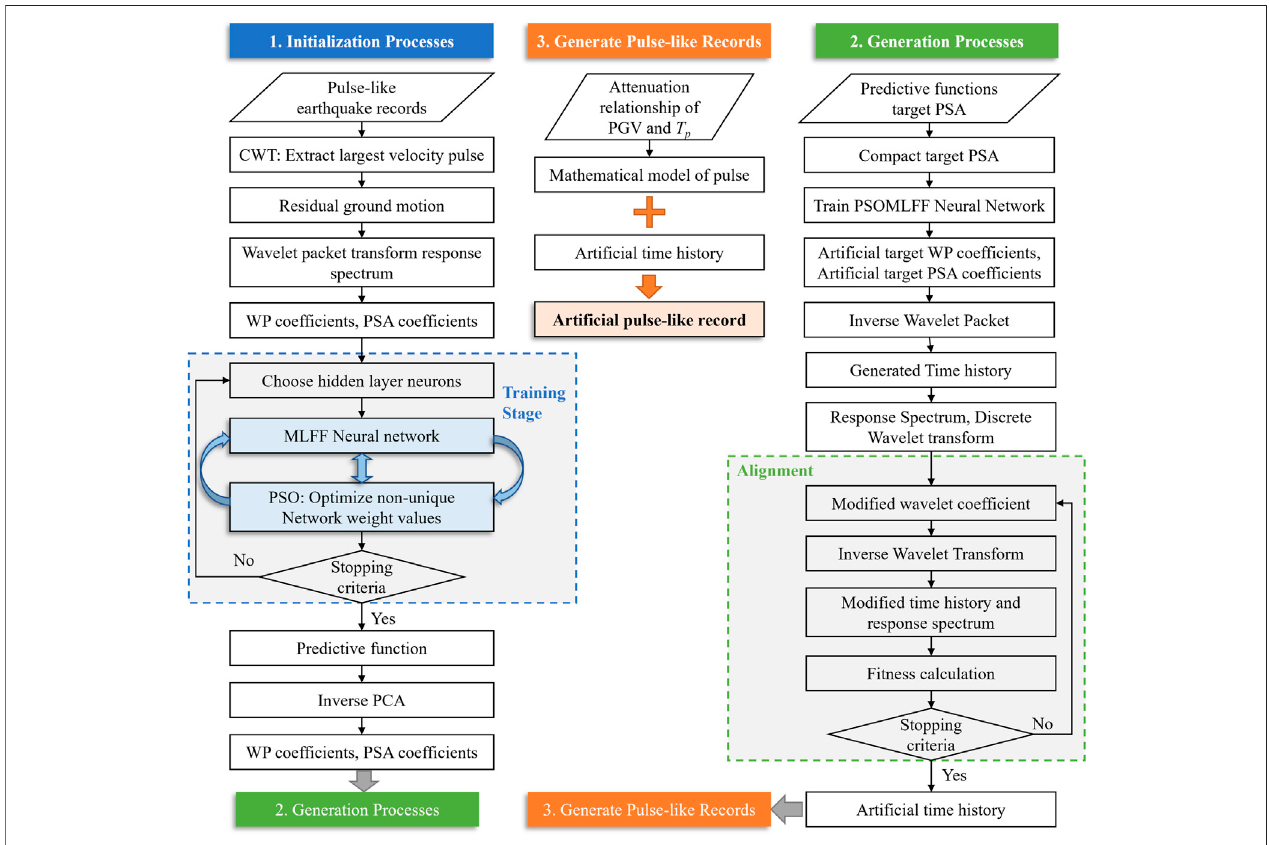
FIGURE 2 | Flowchart for the method using PSO-based neural network (Amiri et al., 2012).